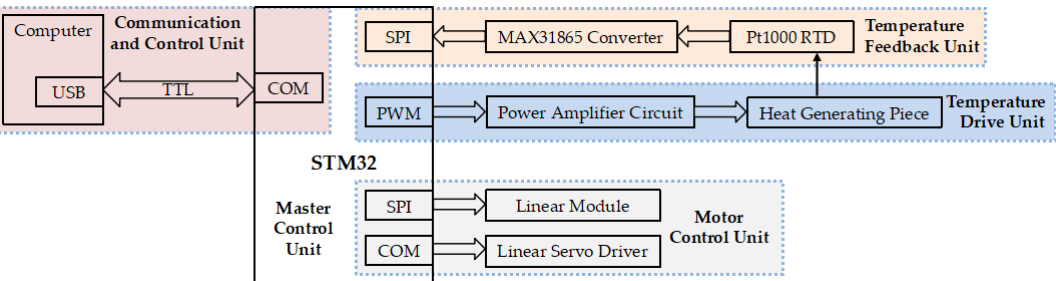
Figure 4. Block diagram of the control unit.